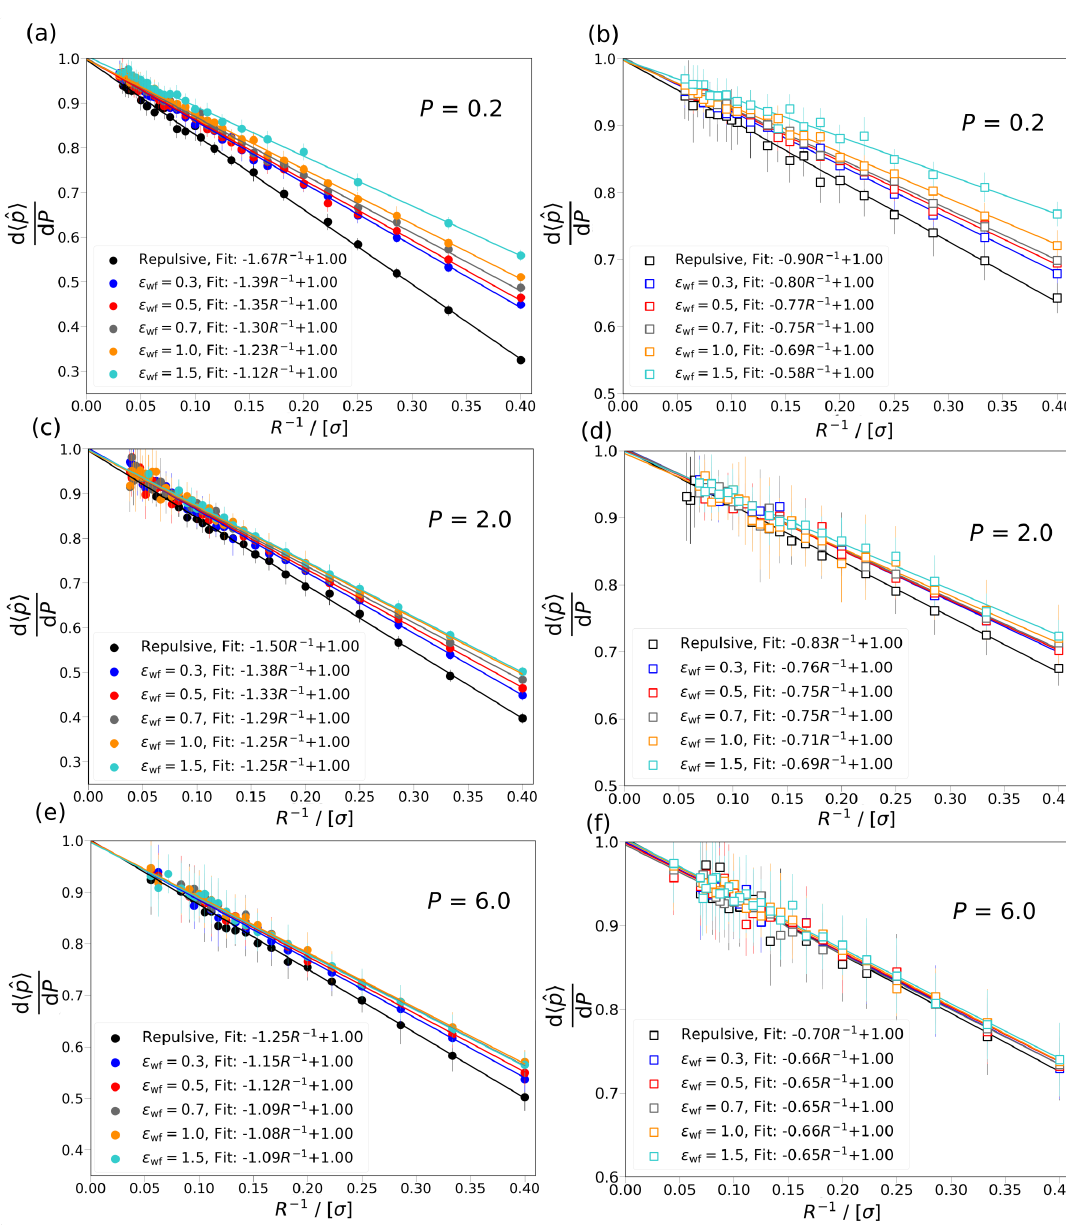
Figure 5. The ratio of driving forces, d (cid:104) ˆ p (cid:105) , is shown as a function of the inverse radius, R − 1 , of d P Box 2 at P = 0.2,2.0, and 6.0 for the cylindrical and slit pore cases with repulsive and attractive (cid:104) ˆ p (cid:105) wall potentials. ( a , c , e ) d is shown for cylindrical pores at differential pressure P = 0.2, 2.0, and d P (cid:104) ˆ p (cid:105) 6.0, respectively. ( b , d , f ) d is shown for slit pores at differential pressures P = 0.2, 2.0, and 6.0, d P respectively. The simulation results are shown with symbols, while the lines are fits to the data points. The equation used for the fitting is AR − 1 + B , where A and B are constants. The results for the cylindrical pore are shown with closed circles and for the slit pores with open rectangles. The colors denote the different wall potential used in Box 2, repulsive wall potential (black), (cid:101) wf = 0.3 (blue), (cid:101) wf = 0.5 (red), (cid:101) wf = 0.7 (gray), (cid:101) wf = 1.0 (orange), and (cid:101) wf = 1.5 (cyan). The temperature of both boxes is set to T = 2. The average densities of Box 1 are ρ ≈ 0.10, 0.58, and 0.8 at P = 0.2, 2.0, and 6.0,